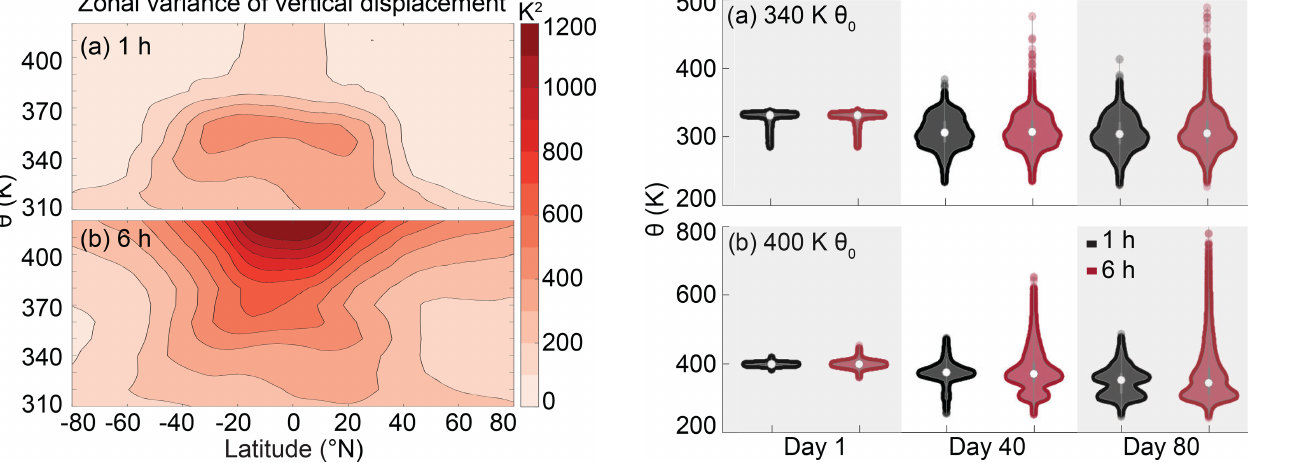
Figure 4. The zonal variance of potential temperature displacement for 1 and 6h trajectories run for 20d with starting heights between 310 and 420K. Contours are at every 100K 2 . The zonal variance of 3h trajectories is shown in Fig. S5.